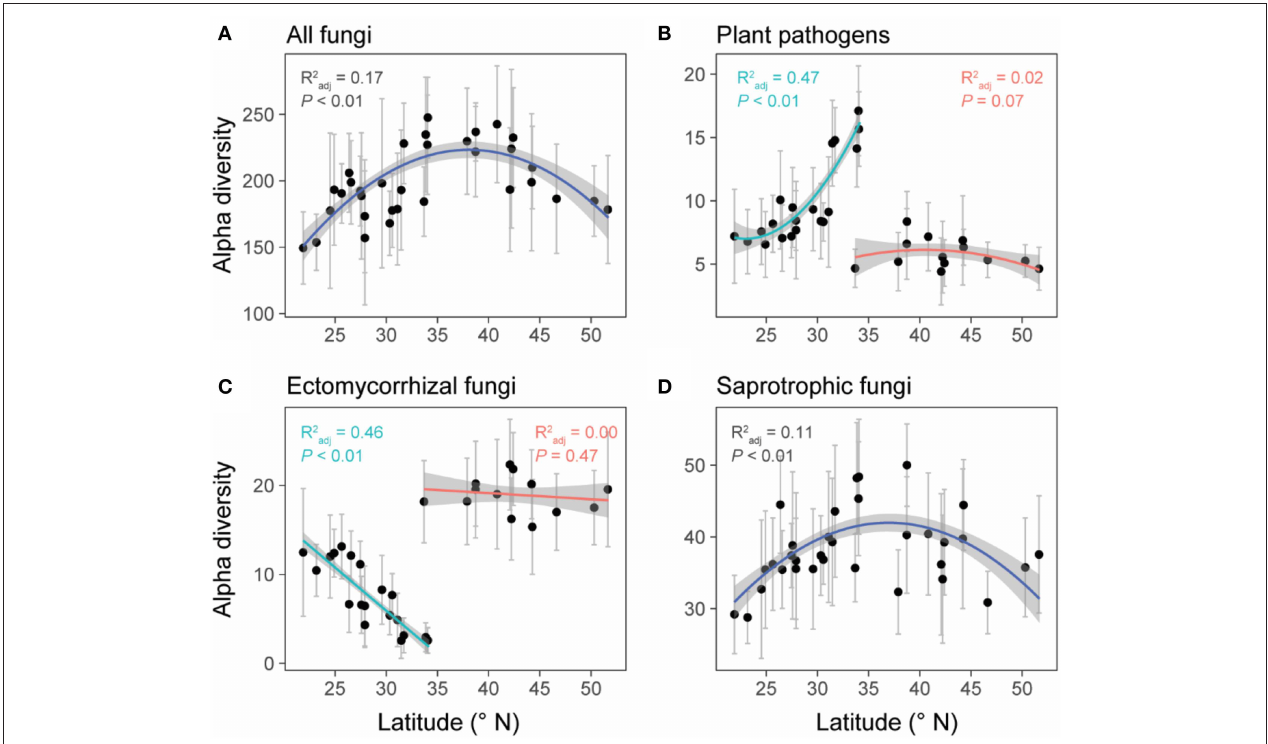
FIGURE 4 | The relationships between latitude and the alpha diversities (OTU level) of all fungi (A) , plant pathogens (B) , ectomycorrhizal fungi (EMF) (C) , and saprotrophic fungi ( D ). Data points represent the mean ( ± SD) alpha diversity of each forest reserve. Linear or polynomial (degree = 2) regression lines were selected to fit the data points based on AIC values. Forest reserves were grouped into two spatial regions (north and south) based on the diversity patterns of plant pathogens and EMF (detailed information showed in methods and Table S1 ). We fitted regression lines to these two regions separately for plant pathogens and EMF. Gray shadows represent 95% confidence